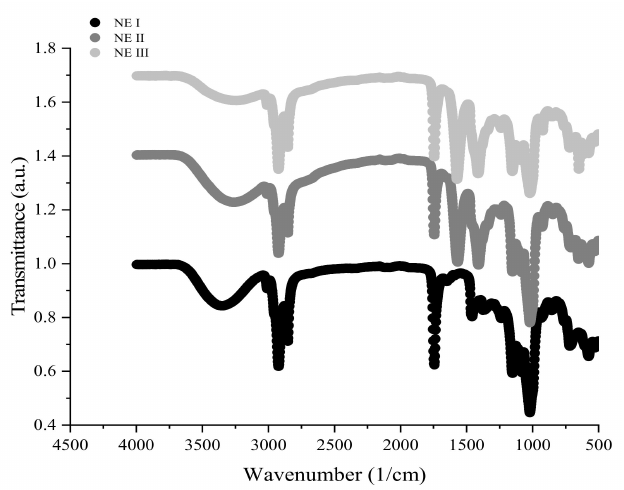
Figure 3. FTIR of 1% OEO-loaded NE I, II, and